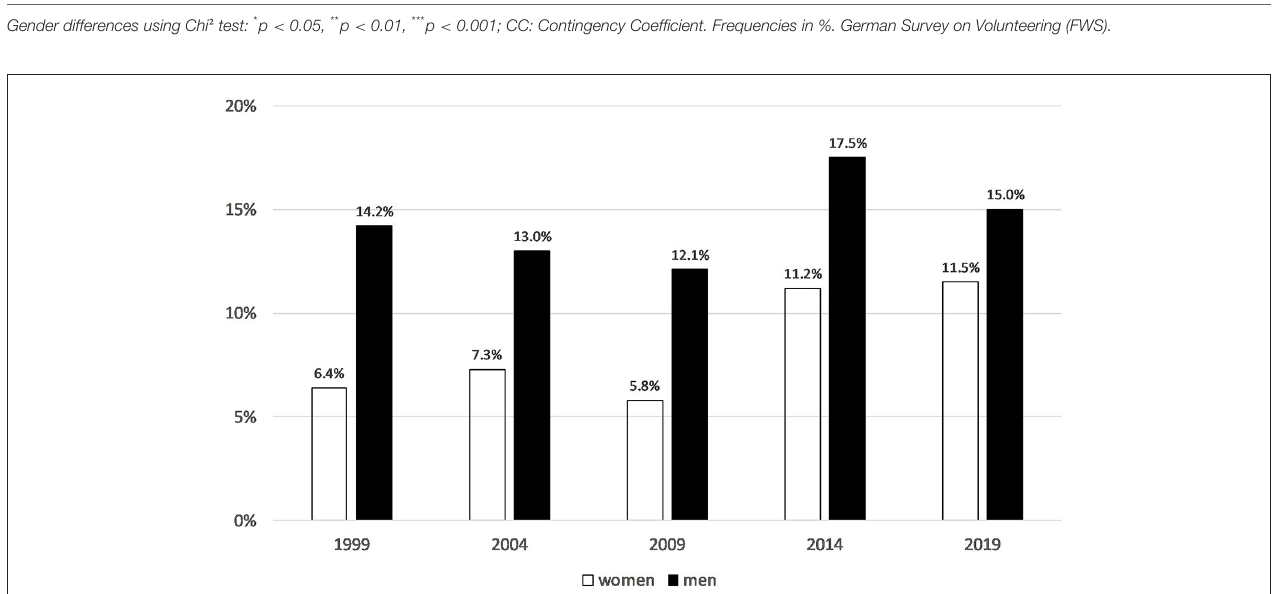
Frontiers in Sports and Active Living |